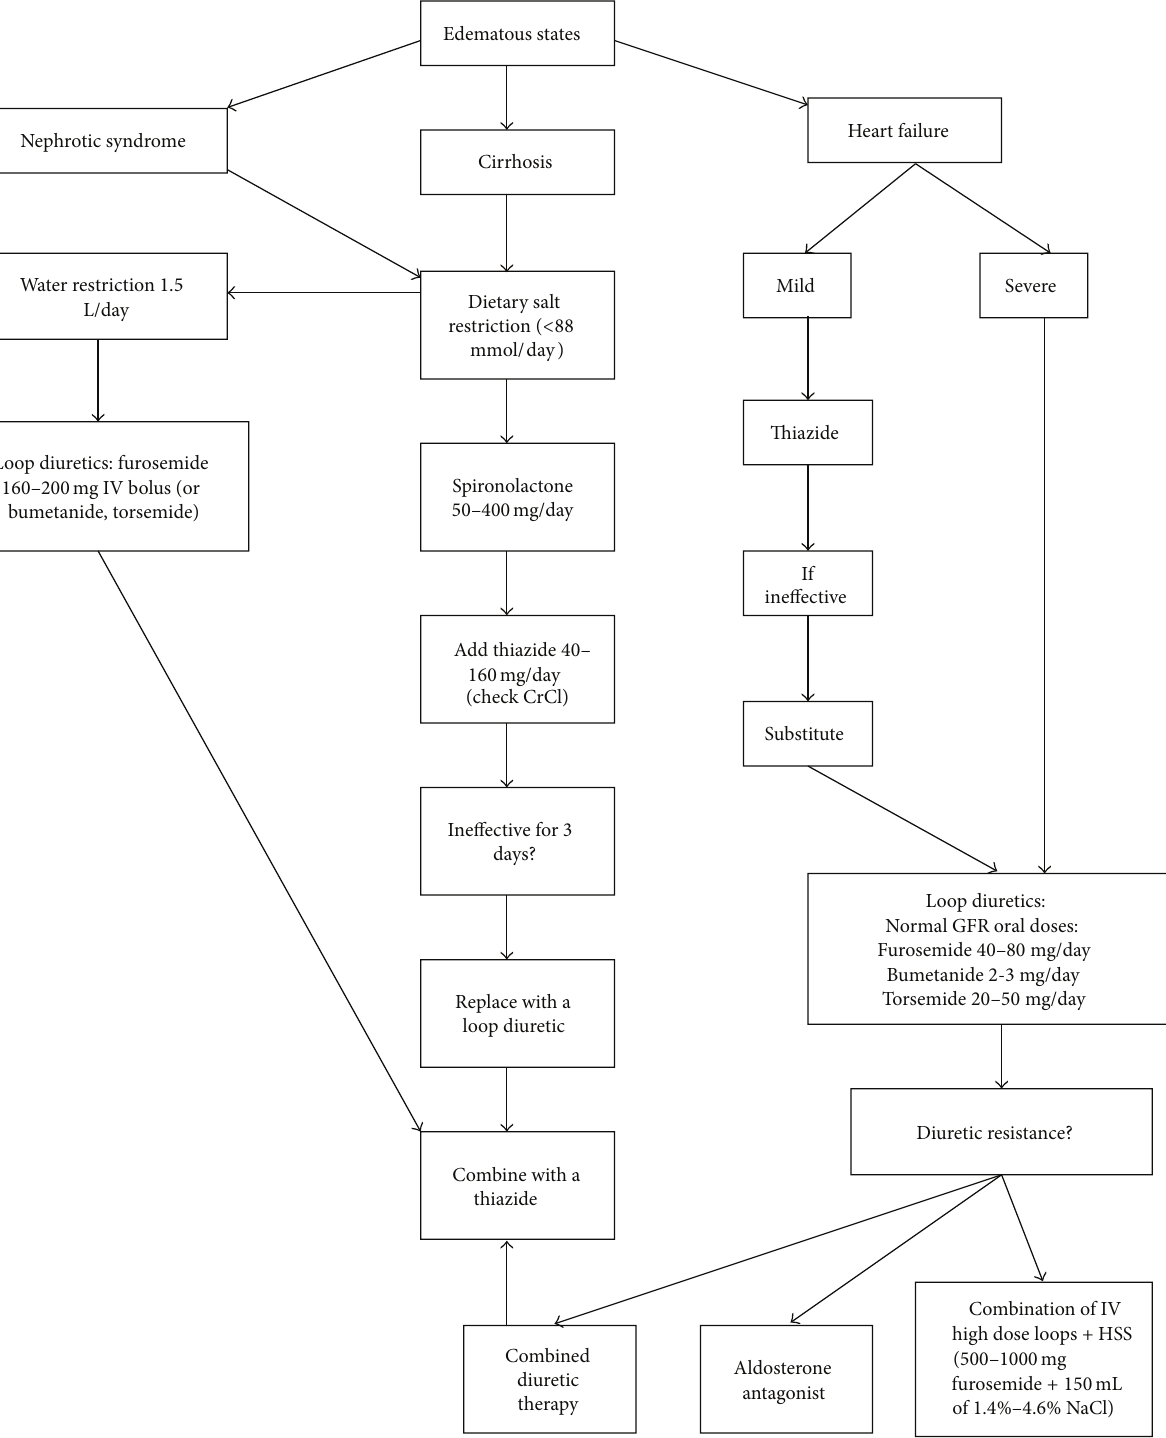
Figure 1: Management of edematous states with diuretics. Abbreviations: HSS: hypertonic saline solution [11, 12, 24, 25, 30–33].